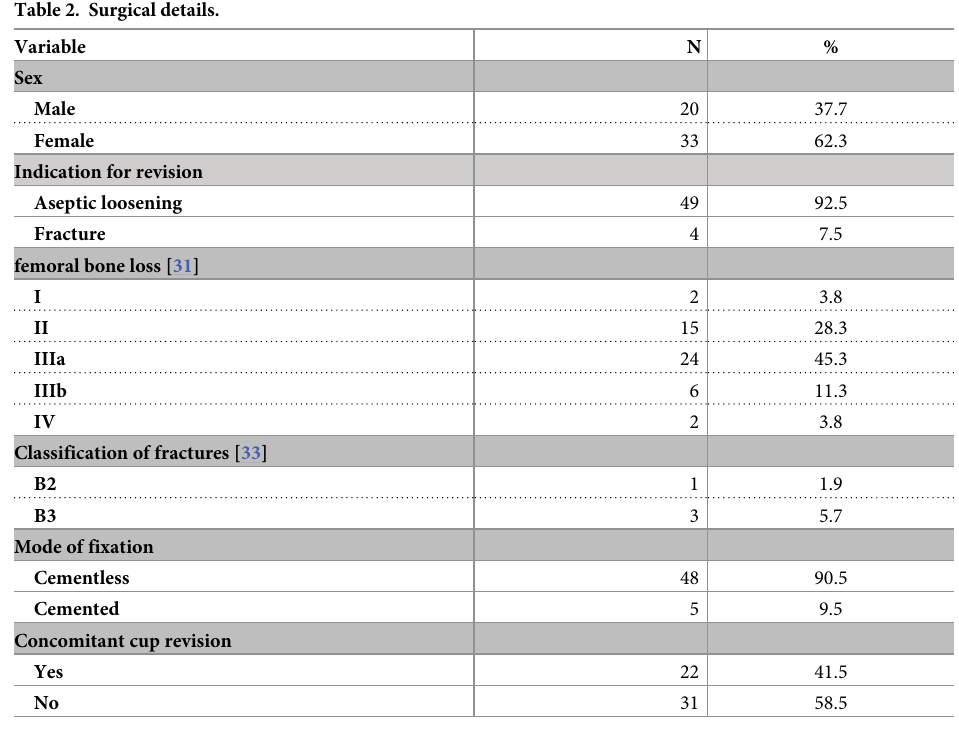
Table 2. Surgical